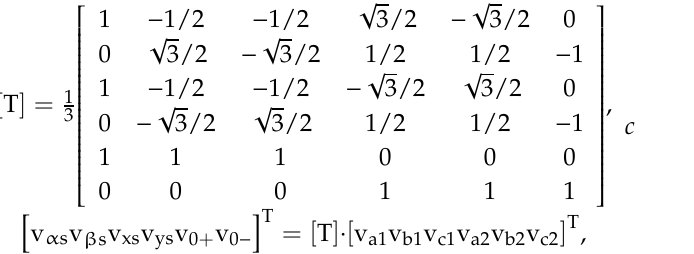
Figure 2. Voltage vectors in 𝛼 - 𝛽 (left plot) and 𝑥 - 𝑦 (right plot) subspaces for an asymmetrical six-phase IM drive.